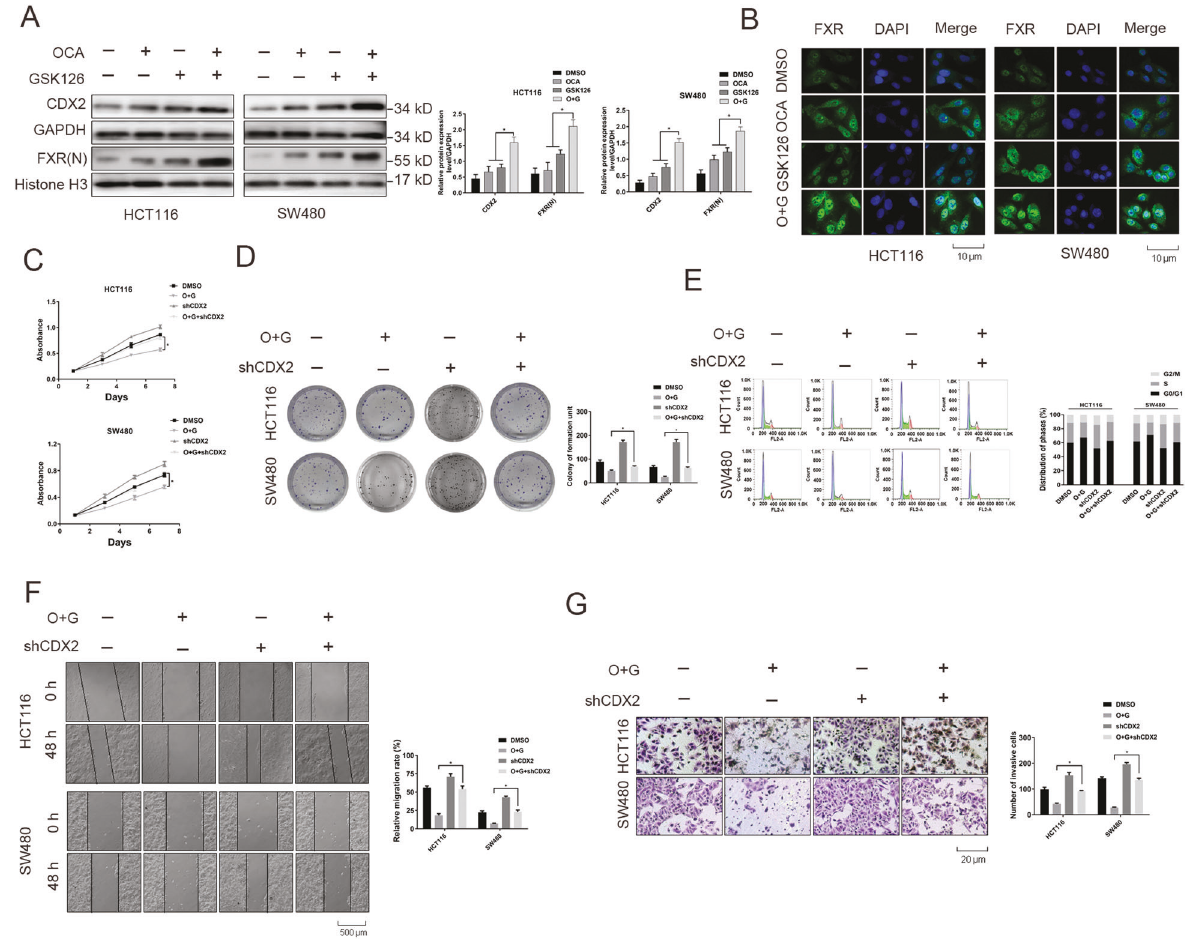
Fig. 4 The depletion of CDX2 antagonized the synergistic effects of the combination of OCA and GSK126 on tumor inhibition. a The protein levels of CDX2 and FXR (nuclear) in HCT116 and SW480 cells treated with OCA and GSK126 alone or in combination by western blotting analysis (left panel: gel bands; right panel: quantitative analysis of these proteins). b The effect of OCA and GSK126 on the nuclear translocation of FXR detected by IF staining. c , d , e The effect of CDX2 depletion on the growth ( c ), colony formation ( d left panel: colony formation assays; right panel: quantitation of the data) and cell cycle distribution ( e left panel: cell cycle analysis assays; right panel: quantitation of the data) of HCT116 and SW480 cells treated with OCA and GSK126 alone or in combination. f, g The effect of CDX2 depletion on the migration ( f left panel: wound-healing assays; right panel: quantitation of the data) and invasion ( g left panel: transwell assays; right panel: quantitation of the data) of HCT116 and SW480 cells treated with OCA and GSK126 alone or in combination. All data are the mean ± SD of three independent experiments. * P <